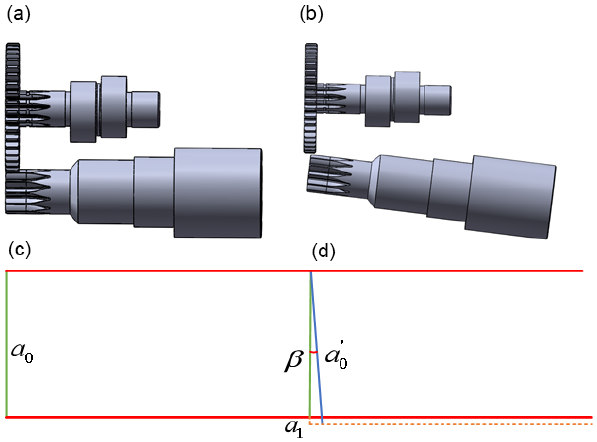
Figure 9. Actual tilt model of input shaft. (a) Normal meshing of input shaft gears (top view), (b) Input shaft gear inclined mesh- ing (top view). (c) Normal parameter model analysis diagram (top view). (d) Analysis diagram of tilt parameter model (top view).